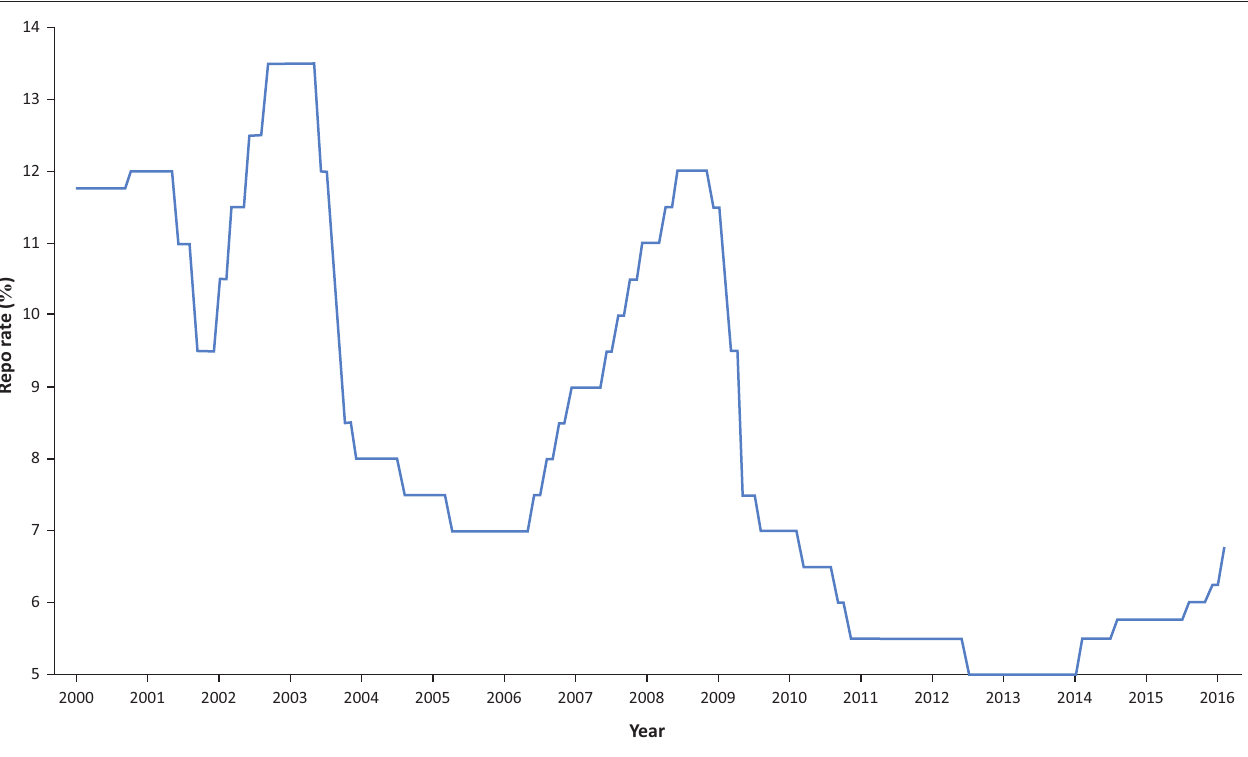
FIGURE 15: South African repo rate post-2000. approximation to an analysis done on daily